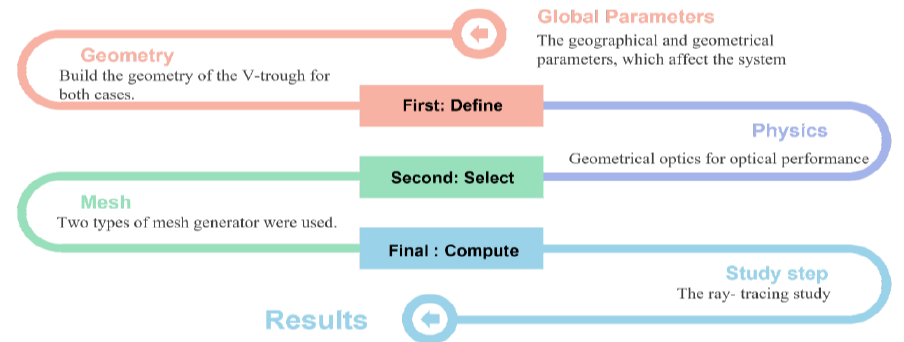
Figure 3. Detailed steps of the COMSOL calculation method structure.